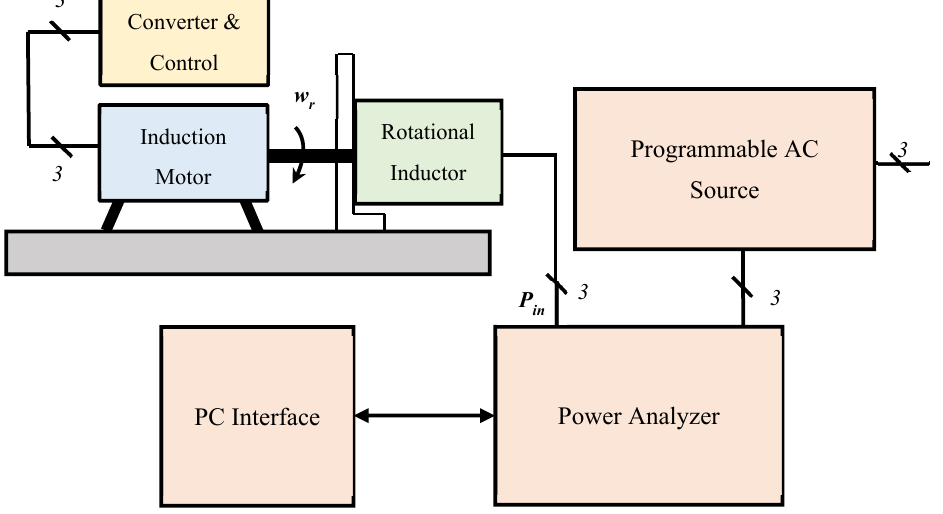
Figure 11. Experimental Setup to Test the Rotational Inductor. When the rotor is standstill and rotating, the rotational inductor is tested at various supply frequencies. At standstill and when the rotor was rotating at supply frequency of 100 Hz, 200 Hz, and 300 Hz, the total inductor losses and peak inductor current of 18 A were measured. Figure 12a shows the measured inductor loss at 18 kRPM and 300 Hz, showing that the inductor losses decrease as the rotor speeds up to its synchronous speed. As the rotor speed increases to the synchronous speed, the percentage of loss reduction also increases. This is because the magnetic field through the rotor of the inductor is rotating synchronously with the rotating magnetic field induced by the stator currents. and negative directions, is shown in Figure 12b. After subtracting the 3-phase copper losses, the iron losses were plotted against the rotor speed. The iron losses are minimum as counterclockwise direction. Where the slip is at 2, the highest point of loss occurs when the rotor is rotating at synchronous speed in the counterclockwise